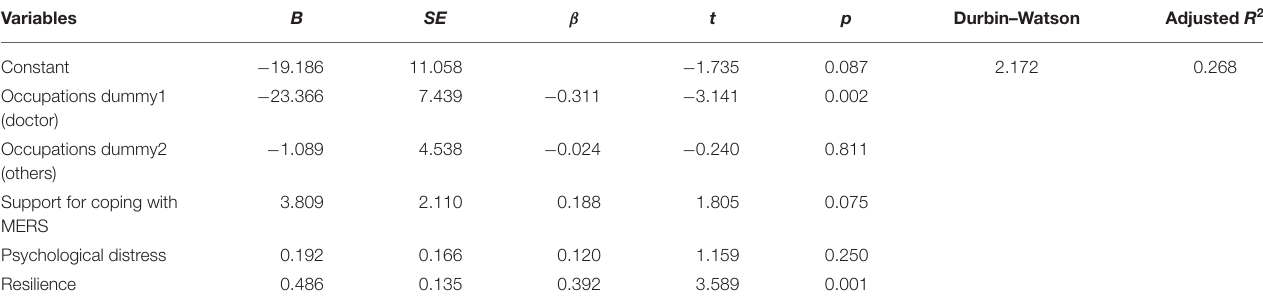
TABLE 6 | Regression model of PTG.